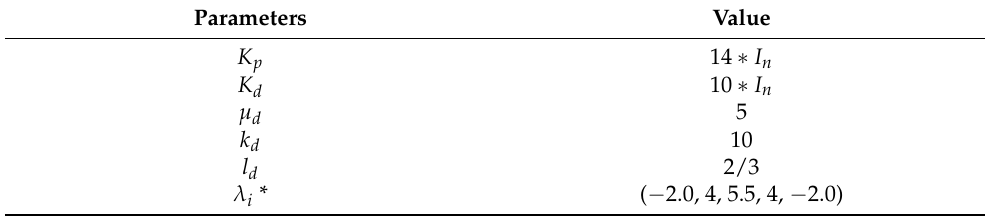
Table 2. Parameters of the controller in simulation. Parameters